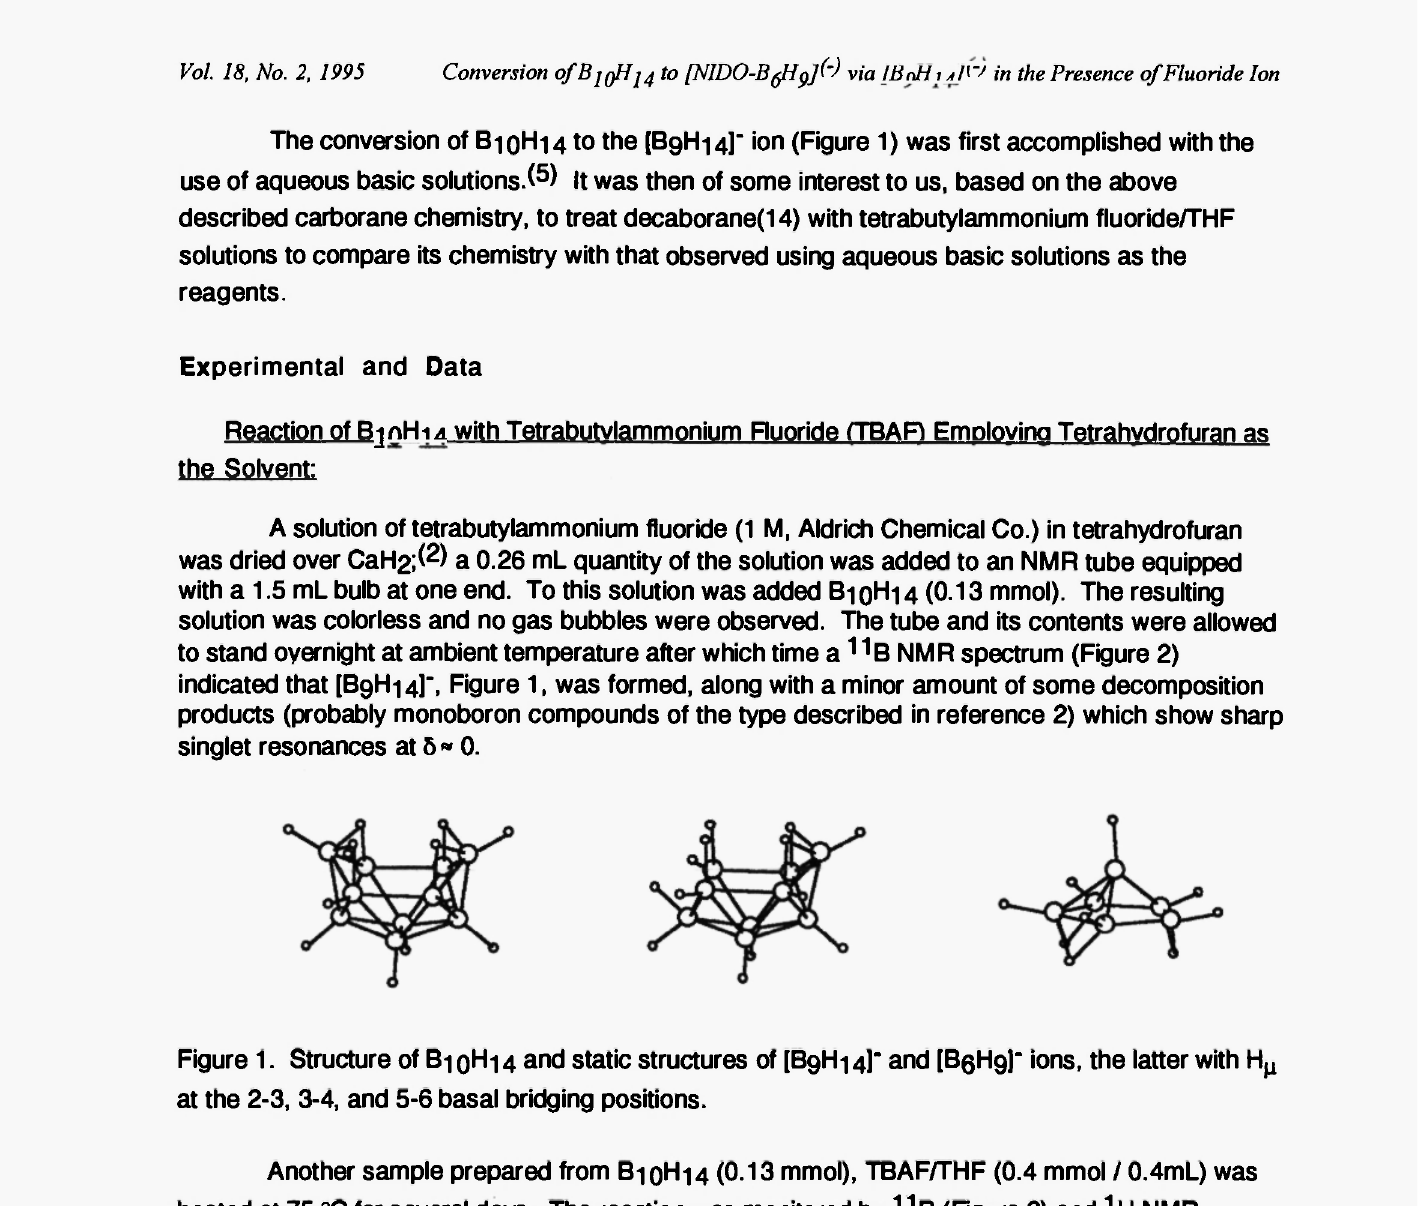
Figure 1. Structure of B10H14 and static structures of [B9H14]· and [BßHgJ· ions, the latter with Η μ at the 2-3, 3-4, and 5-6 basal bridging